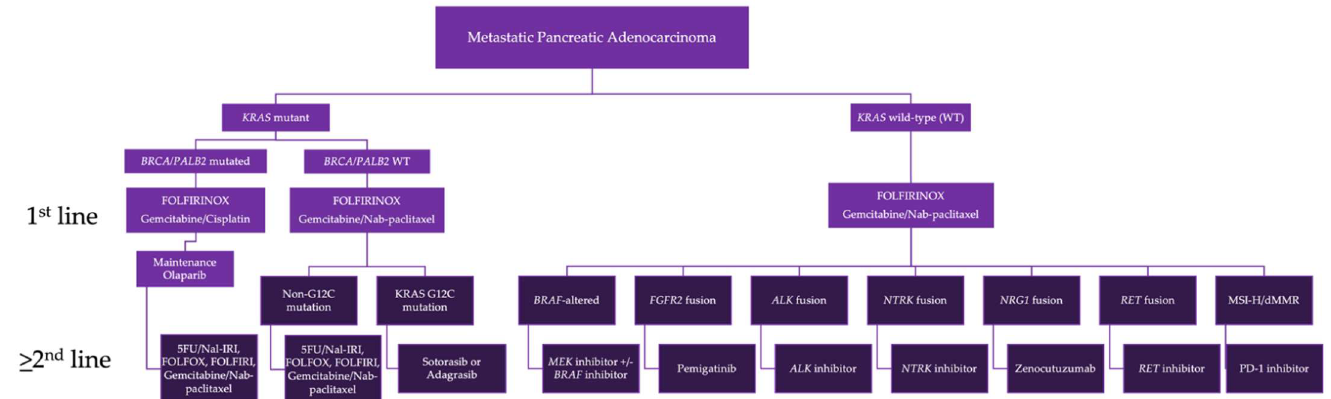
Figure 2. Biomarker-driven treatment paradigm for metastatic pancreatic adenocarcinoma. Treat- ment algorithm describes first-line, maintenance, and second-line treatment options for PDAC patients, based upon the tumor’s molecular alterations. Multiple treatment options are listed in in- stances where more than one therapy is available. Abbreviations used include: FOLFIRINOX: folinic acid, 5-fluorouracil, irinotecan, and oxaliplatin; FOLFOX: folinic acid, 5-fluorouracil, and oxali-